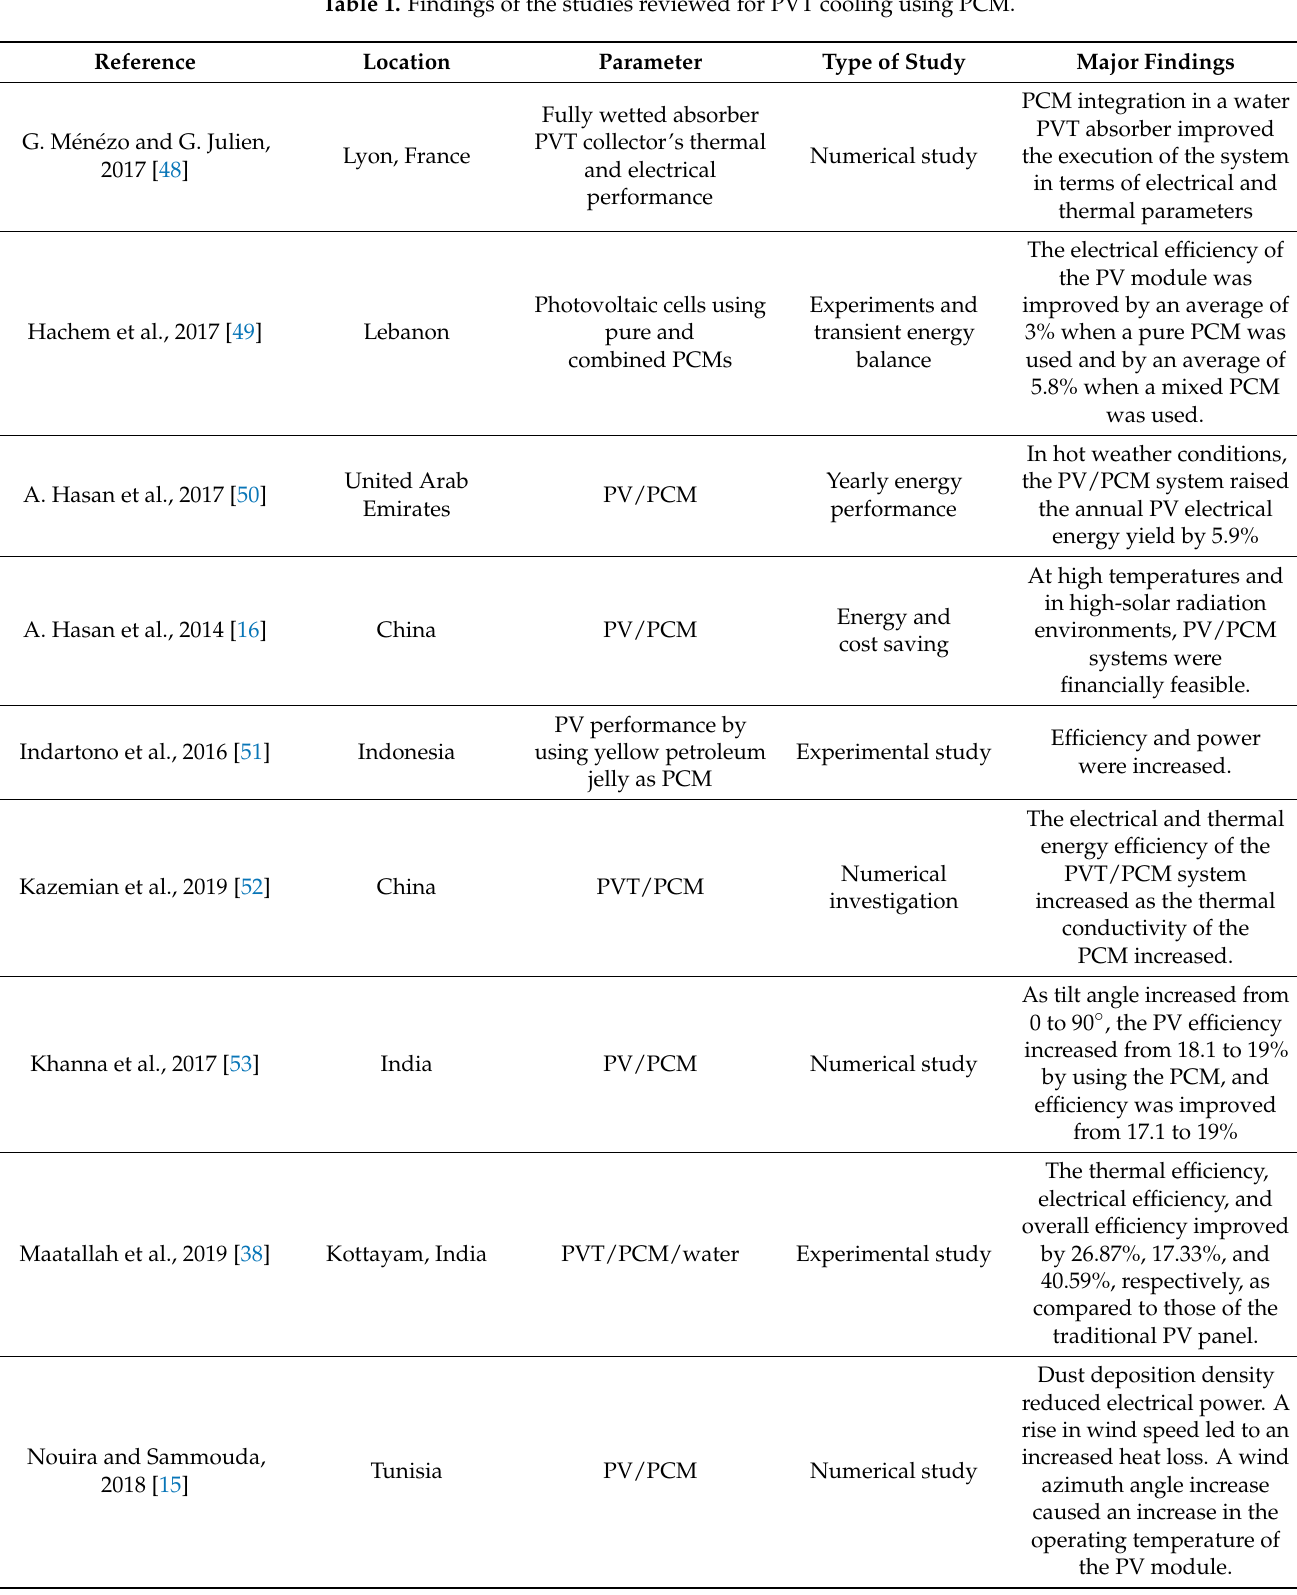
Table 1. Findings of the studies reviewed for PVT cooling using